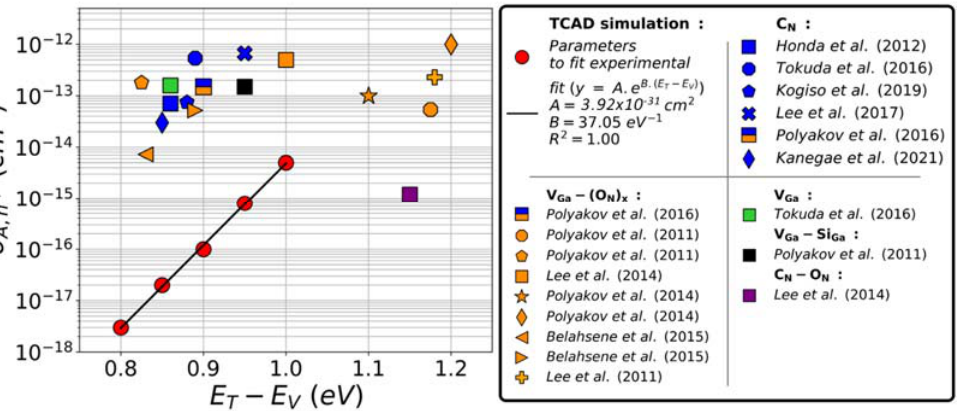
Figure 9. Acceptor traps’ cross ‐ section as a function of their energy with respect to the valence band. Colors refer to the hypothesis proposed by the authors [35–45] (C N : carbon on the N ‐ site; V Ga ‐ (O N ) x : gallium vacancy with oxygen atom(s) on the N ‐ site; V Ga : gallium vacancy; V Ga ‐ Si Ga : gallium vacancy with a silicon atom on the Ga ‐ site; C N ‐ O N : carbon on the N ‐ site with an oxygen atom on the N ‐ site).